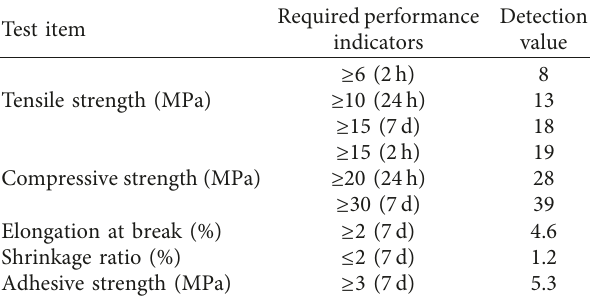
Table 2: The major mechanical properties of the cured